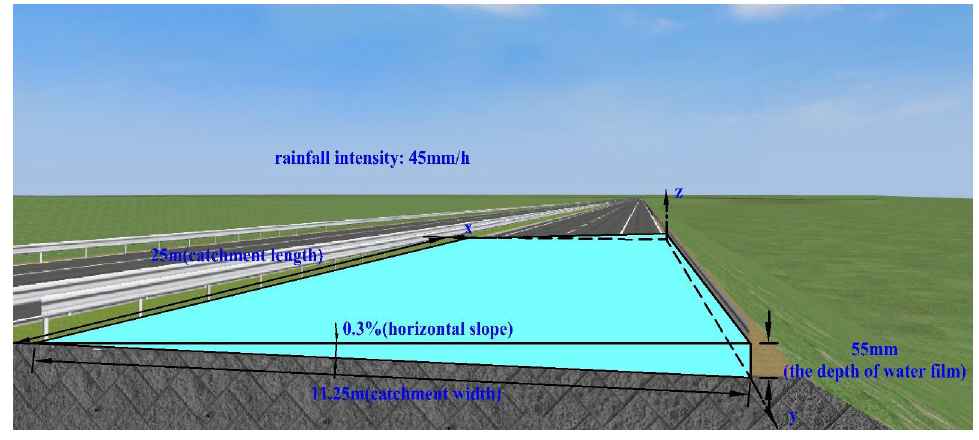
Fig 13. Schematic of the water film depth (Model